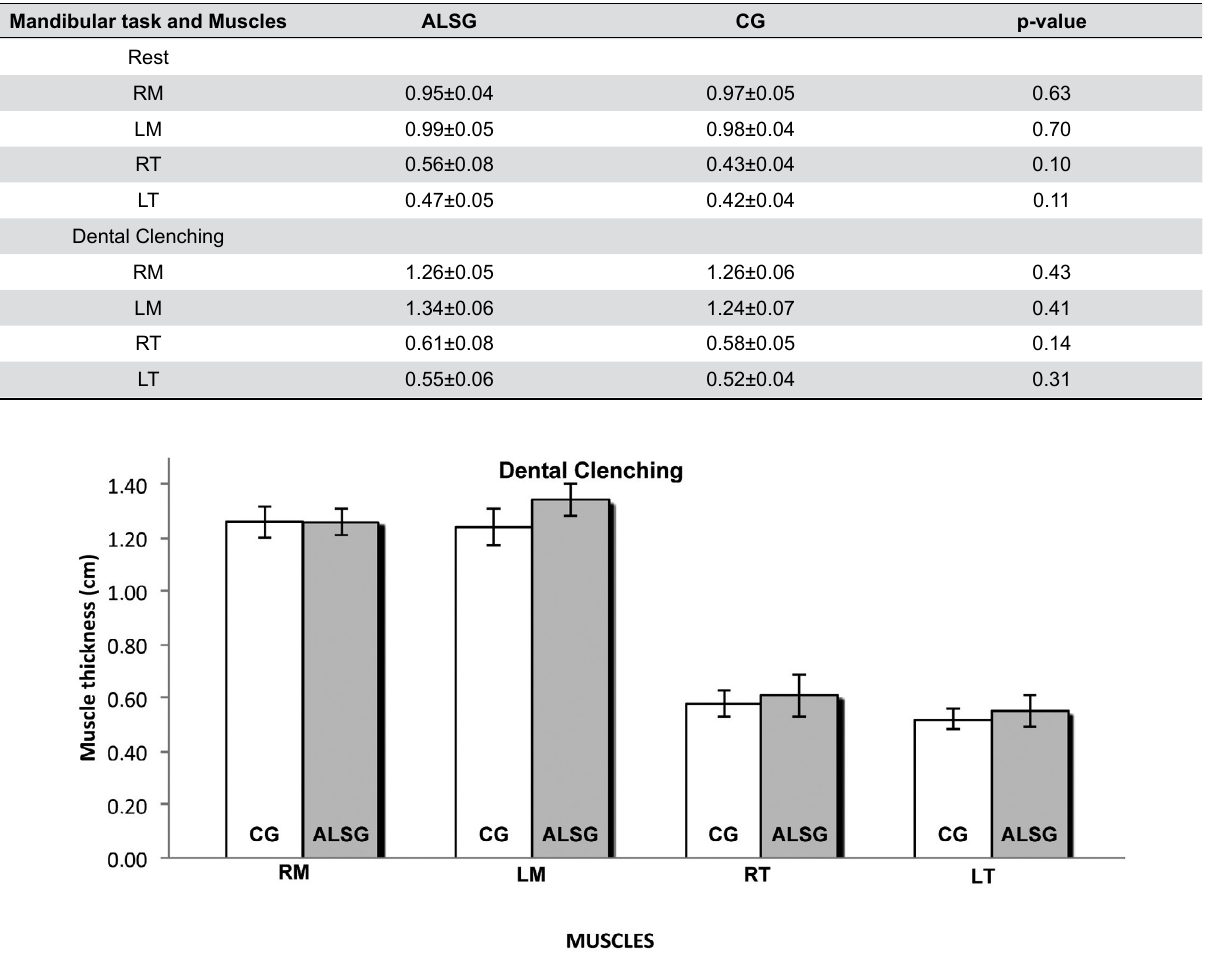
Figure 10- Masticatory muscle thickness data of masseter (RM: right masseter; LM: left masseter) and temporalis (RT: right temporal; LT: left temporal) muscles for CG and ALSG in the dental clenching